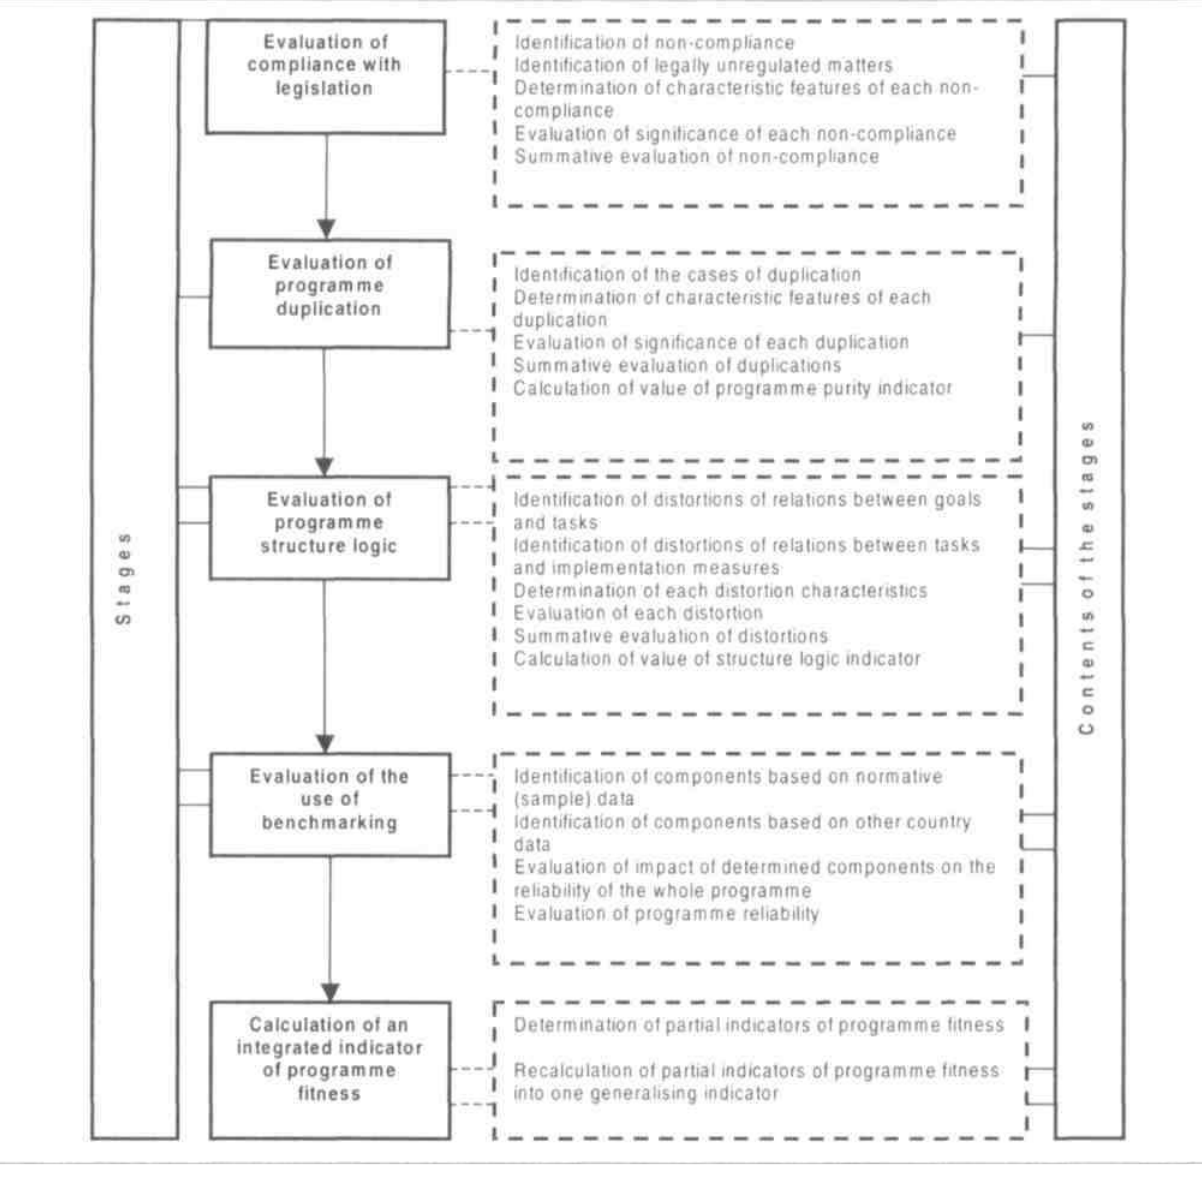
Fig 5. Principal scheme of the evaluation of programme